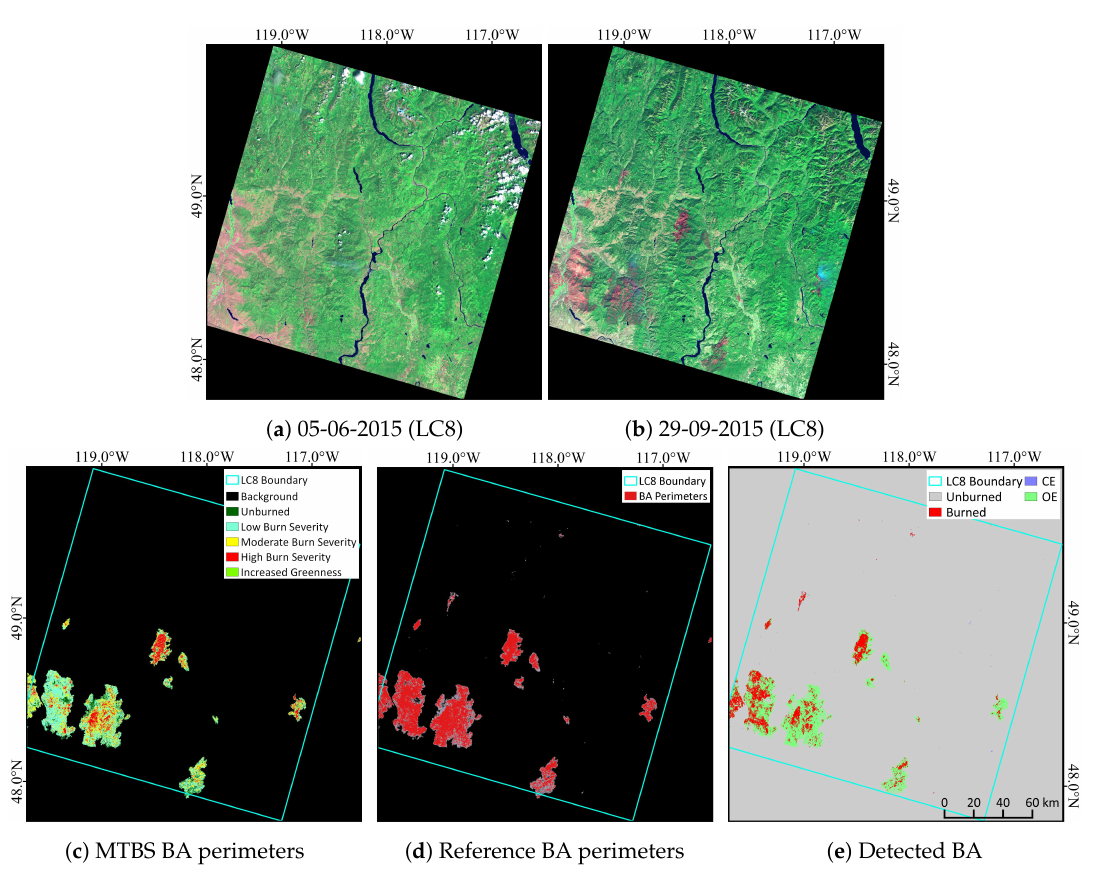
Figure A5. Comparison between MTBS and detected BA. ( a , b ) are the Landsat-8 images (path/row:044/ 026) displayed in false color composition (red: SWIR2 band, green: NIR band, and blue: green band); ( c ) is the MTBS perimeters of 2015; ( d ) shows reference BA perimeters generated from Landsat-8 images and MTBS perimeters of 2015; and ( e ) shows burned areas generated by the proposed method with CE and